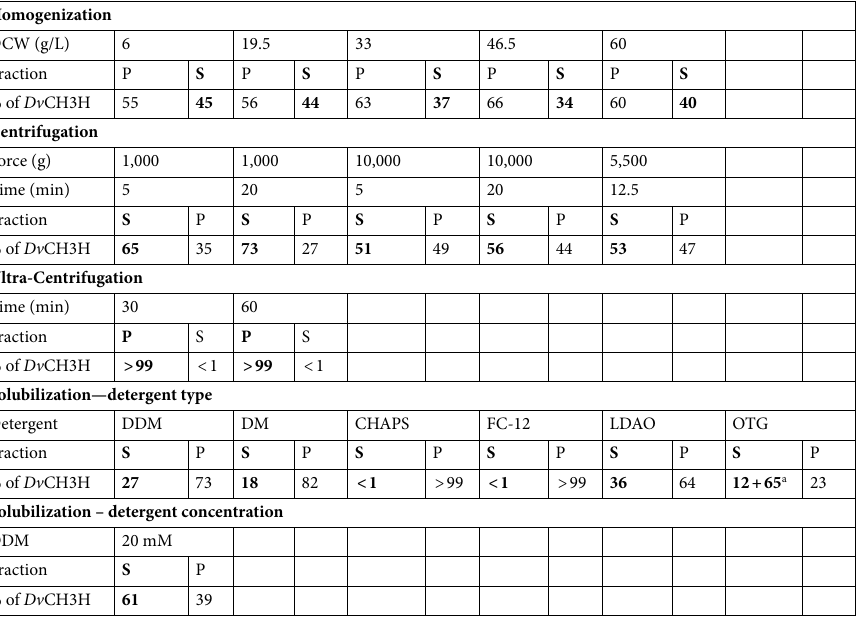
Table 1. Results of western blots with percentages of recombinant Dv CH3H in supernatants (S) and pellets (P). The fractions that were further processed are marked in bold. DDM: n-Dodecyl β-D-maltoside; DM: n-Decyl-β-D-maltoside; CHAPS: 3-((3-Cholamidopropyl) dimethylammonio)-1-propanesulfonate; FC-12: Fos-choline-12; LDAO: Dodecyldimethylaminoxid; OTG: Octylthioglucoside. a OTG fractionated the protein during SDS-PAGE, therefore two different bands were detected on the Western blot. The 12% band was at the correct size whereas the 65% band was much smaller. Average standard deviation of the results is 6.4%. Western blots for the homogenisation and the detergent type are provided in Supplementary Fig. 2.